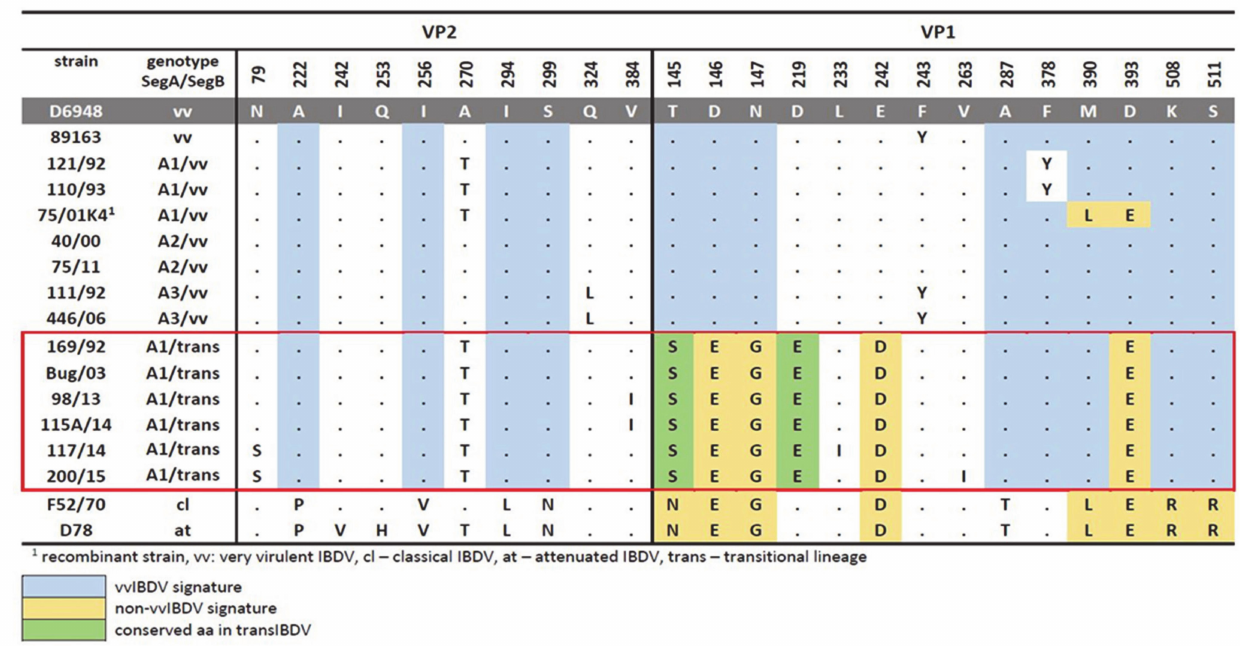
Figure 1. Comparison of amino acid substitutions at different positions on VP2 and VP1 proteins between Polish IBDV and reference strains. Dots show an identity with D6948. A—alanine, R—arginine, N—asparagine, D—aspartic acid, Q—glutamine, E—glutamic acid, G—glycine, H—histidine, I—isoleucine, L—leucine, K—lysine, M—methionine, F— phenylalanine, P—proline, T—threonine, Y—tyrosine,